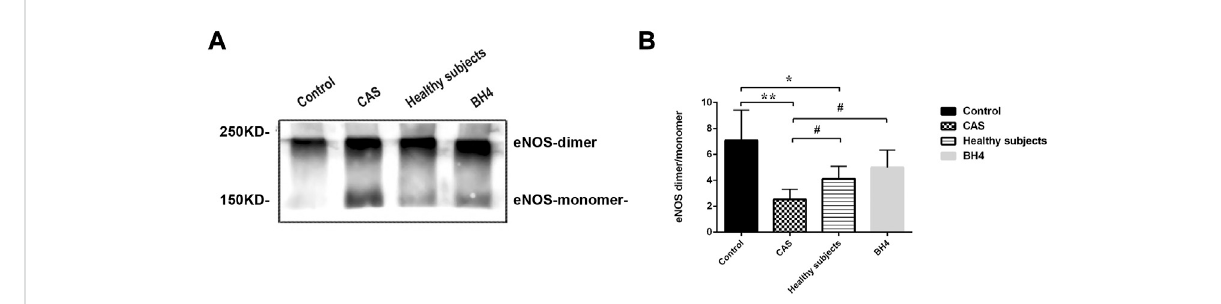
FIGURE 5 (A,B) DetectionofeNOSbyWesternblot( n =4pergroup).Valuesareshownasmeans±SD.* p < 0.05,** p < 0.01vs.controlgroup; # p < 0.05vs. CAS